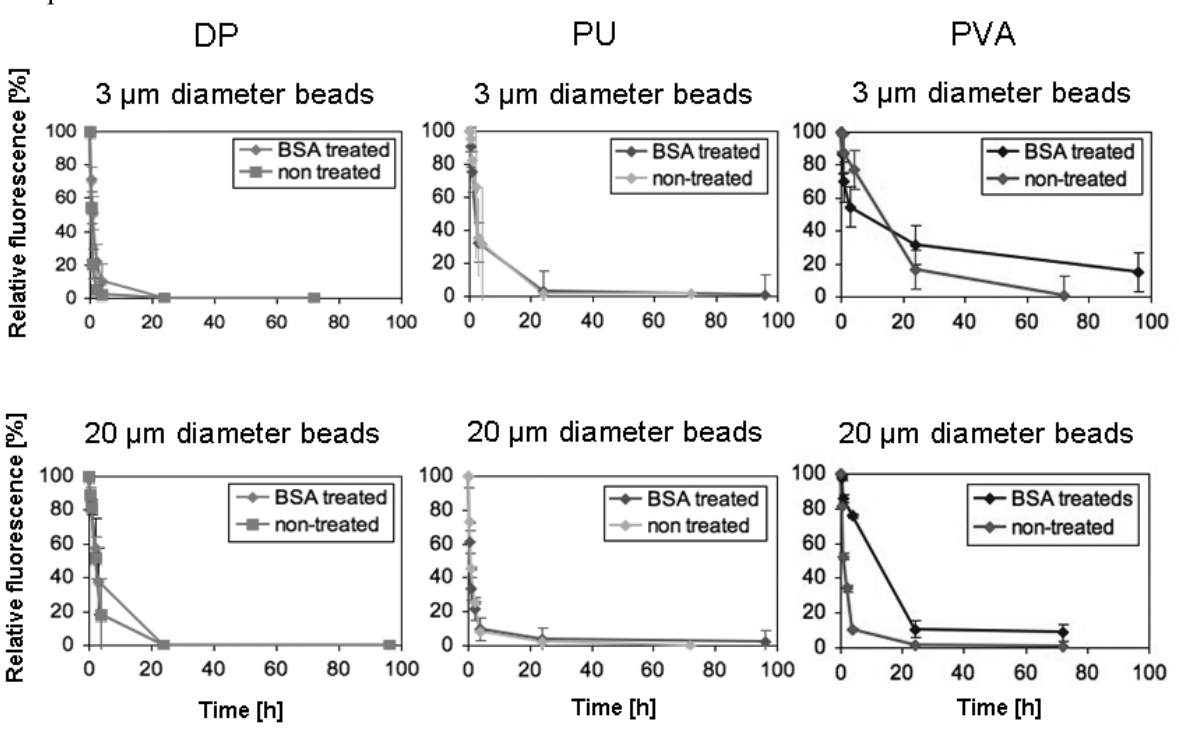
Figure 3. Effect of pre-adsorption with bovine serum albumin of fluorescent beads on perfusion